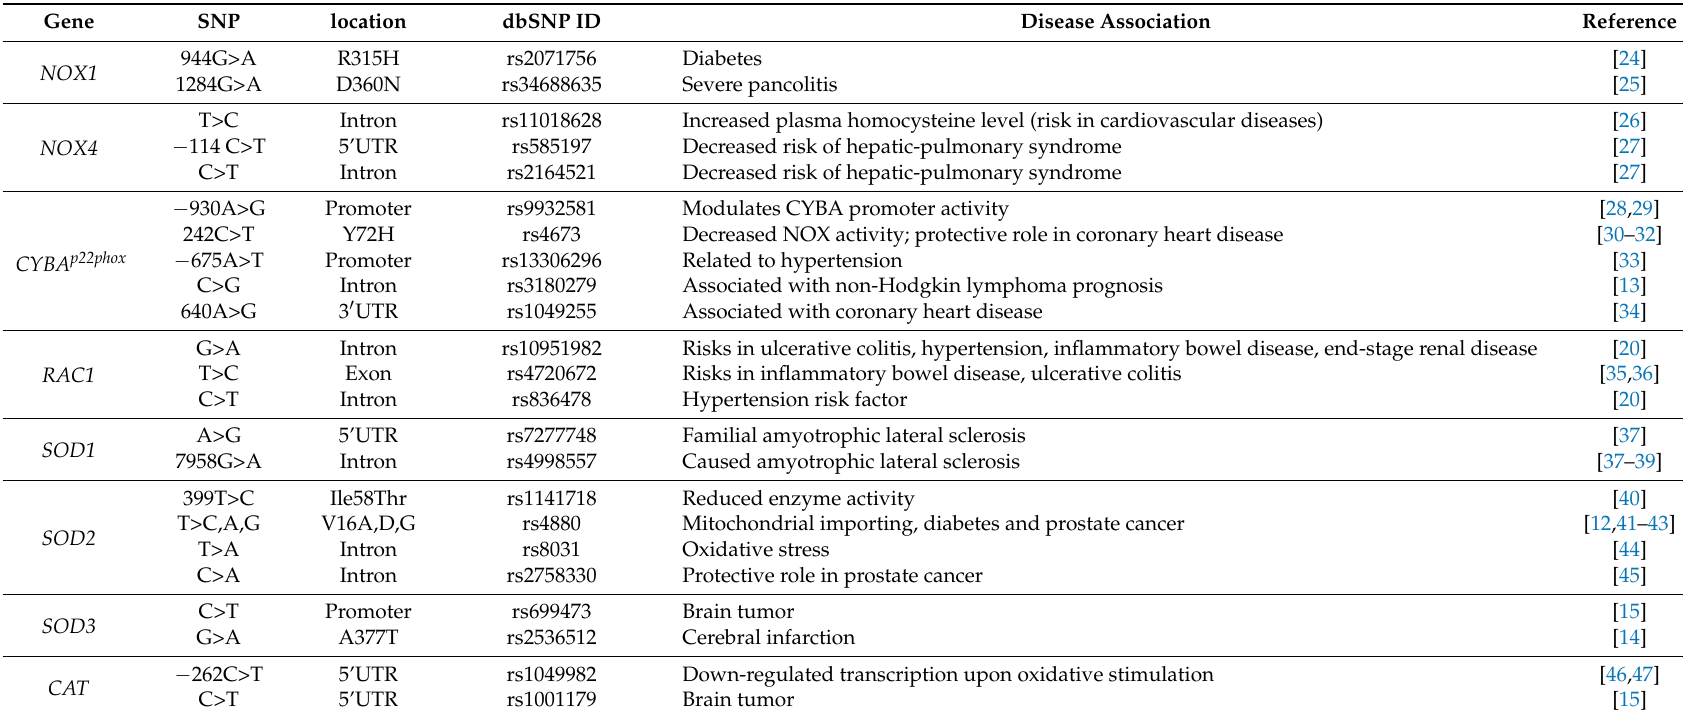
Table 2. Twenty-three SNP